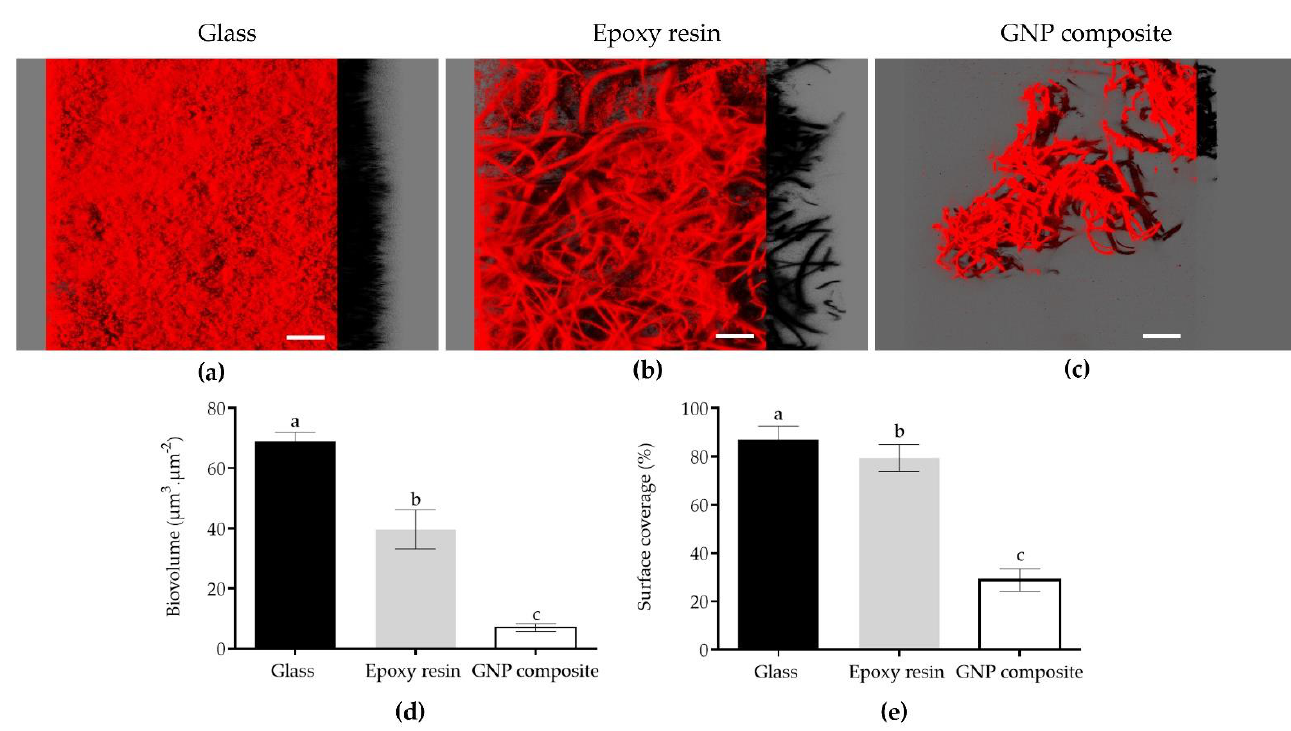
Figure 7. Three-dimensional confocal reconstructions of Lusitaniella coriacea LEGE 07157 biofilms grown on ( a ) glass, ( b ) epoxy resin, and ( c ) GNP composite after 49 days of incubation (white scale bars = 50 µm). These images show the biofilm aerial view, with the virtual shadow projection on the right (representative of biofilm thickness). Biovolume ( d ) and surface coverage ( e ) values of cyanobacterial biofilms were extracted from confocal files with the COMSTAT program. The means ± SD are presented. Different letters in the graphs (a, b, and c) indicate a significant difference among surfaces ( p < 0.05).